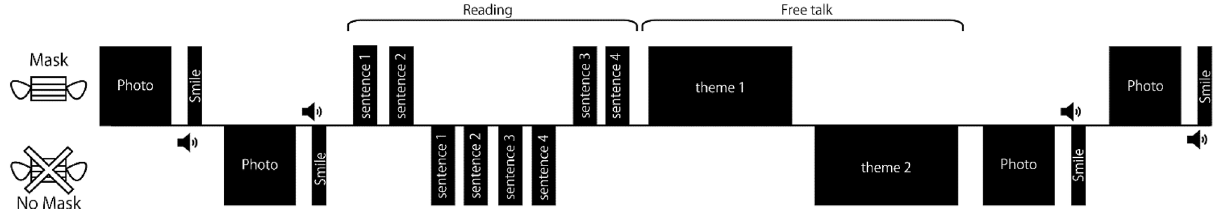
Figure 1. Schematic representation of the experimental